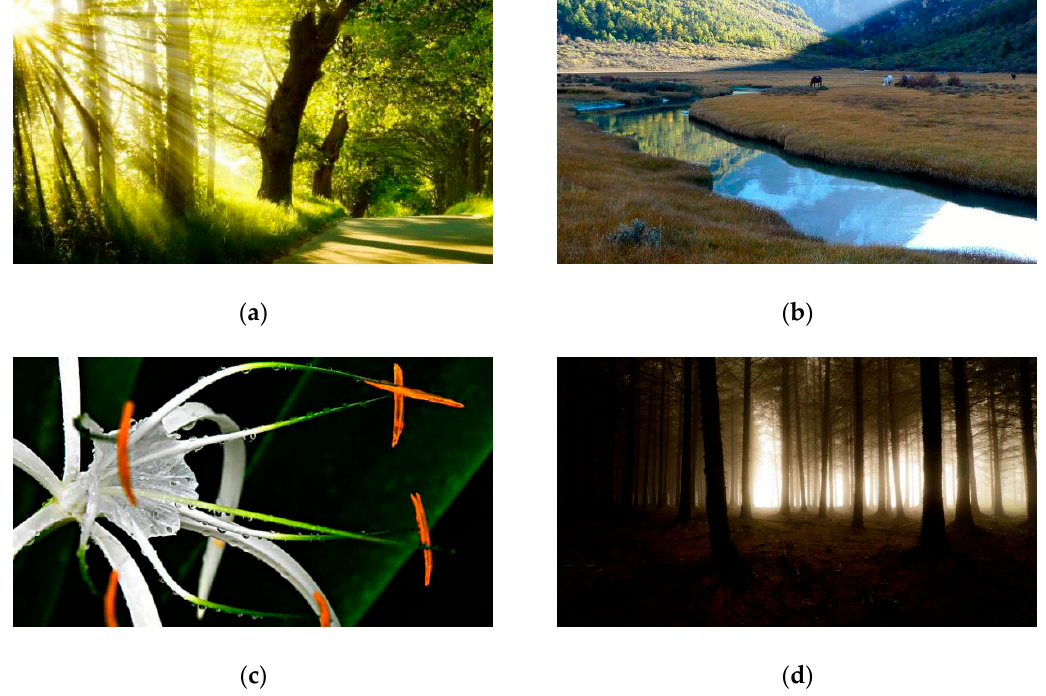
Figure 5. Test images 1, 2, 3, and 4. Images 1 and 2 are two low contrast ratio images, and Images 3 and 4 are two high contrast ratio images. ( a ) Image 1, ( b ) Image 2, ( c ) Image 3, ( d ) Image